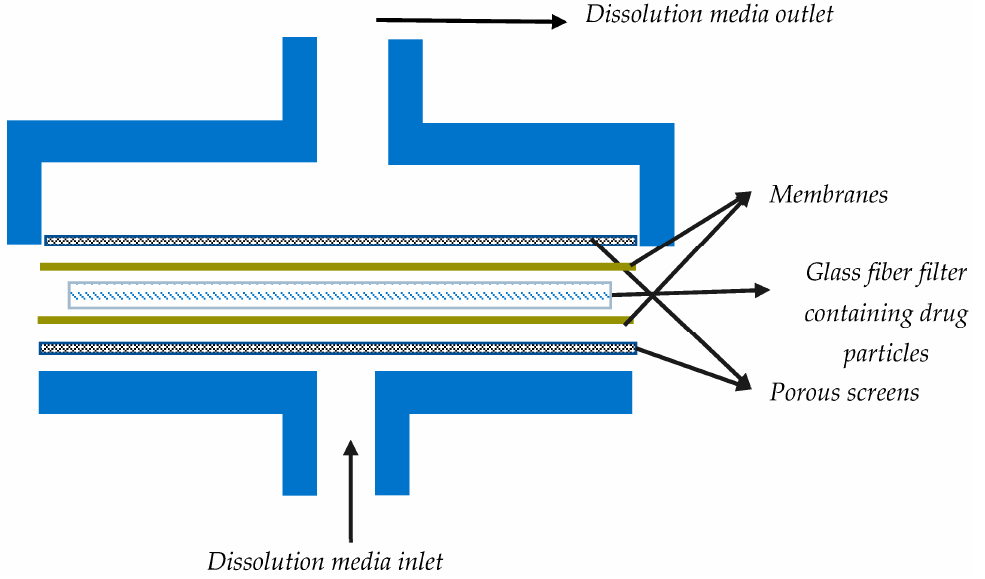
Figure 4. A rough schematic of a dissolution cell (containing the filter) for dissolution testing of powders in flow through systems.